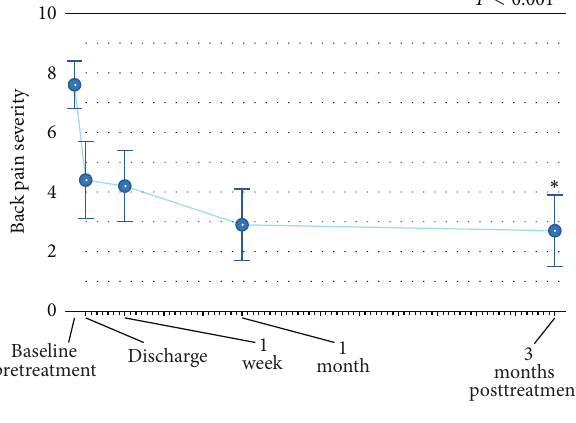
Figure 3: Improvement in back pain through 3 months following radiofrequency-targeted vertebral augmentation. Values are mean ± 95% confidence intervals.